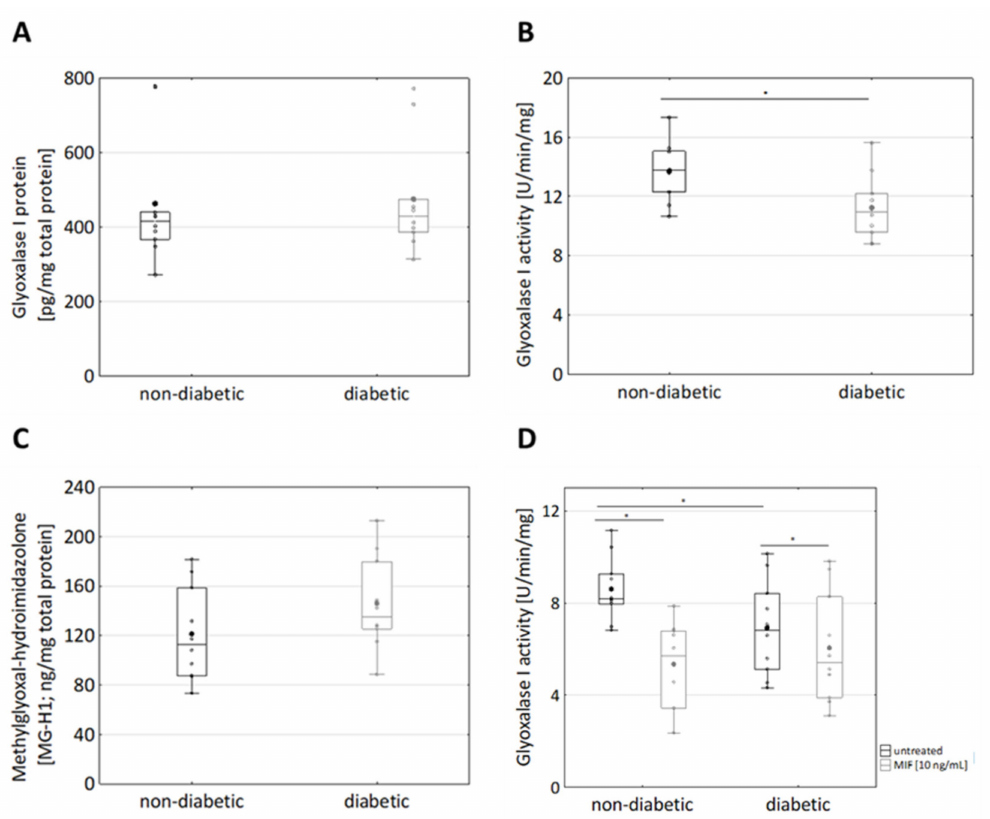
Figure 4. Glyoxalase I system in non-diabetic and diabetic dermal fibroblasts. Cultured fibroblasts from diabetic and non-diabetic donors were lysed by adding PBS and 3 freeze/thaw cycles. ( A ) The expression of glyoxalase I protein was measured via ELISA; n non-diabetic = 10; n diabetic = 10. ( B ) Glyoxalase I activity was analysed in terms of formation of S-D-lactoylglutathione, which was photometrically measured as a change in absorbance at 240 nm. Statistical significance was determined by Mann–Whitney-U-Test between groups and by Wilcoxon test for comparison between untreated and treated, * p < 0.05, n non-diabetic = 10; n diabetic = 10. ( C ) 5-hydro-5-methylimidazolone (MG-H1) was detected in lysates of diabetic and non-diabetic fibroblasts. ( D ) Fibroblasts from diabetic and non-diabetic donors were pre-treated with 10 ng/mL MIF for 24 h and lysed by adding PBS and three freeze/thaw cycles. Glyoxalase I activity was analysed in terms of formation of S-D-lactoylglutathione, which was photometrically measured as a change in absorbance at 240 nm. n non-diabetic = 10; n diabetic =